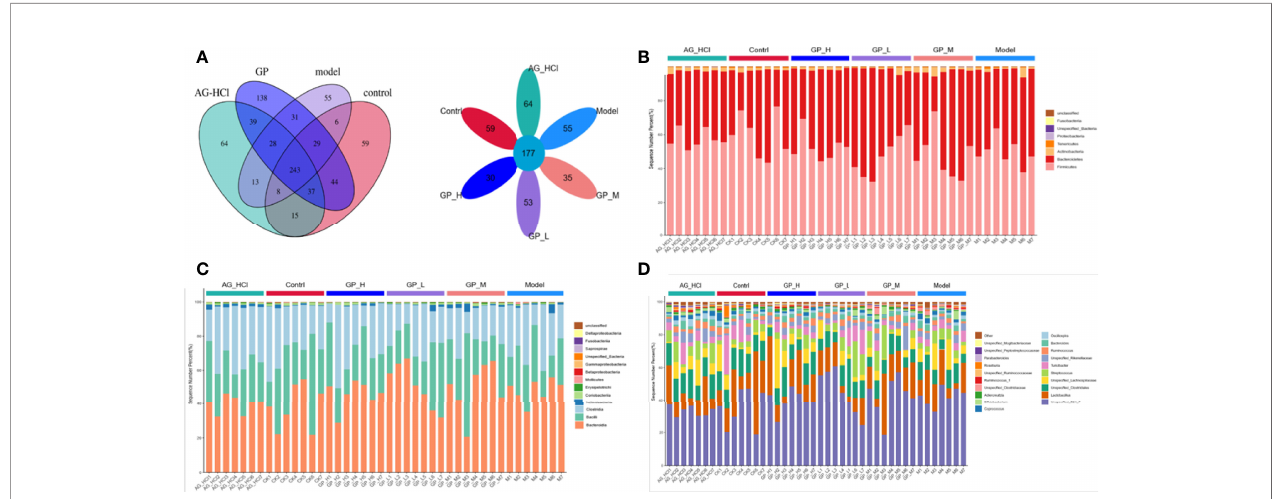
FIGURE 6 | Venn and Flower plot of mice intestinal micro fl ora of OTUs (A) . Relative abundance of mice intestinal micro fl ora on phylum (B) class (C) and genus (D)